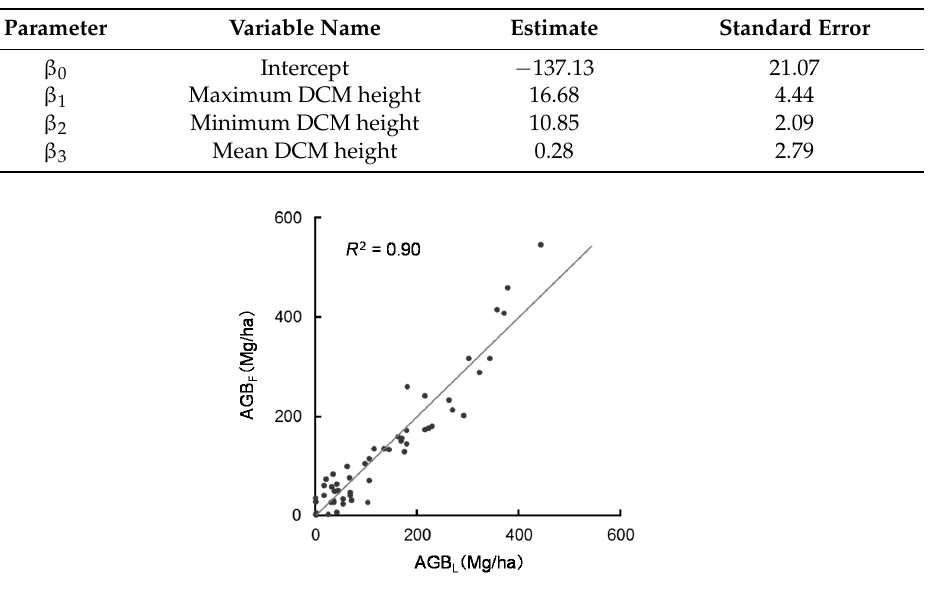
Figure 5. The relationship between AGB in the sample plots obtained from the field survey (AGB F ) and AGB in the sample plots predicted by the LiDAR-based model (AGB L ). and AGB in the sample plots predicted by the LiDAR-based model (AGB